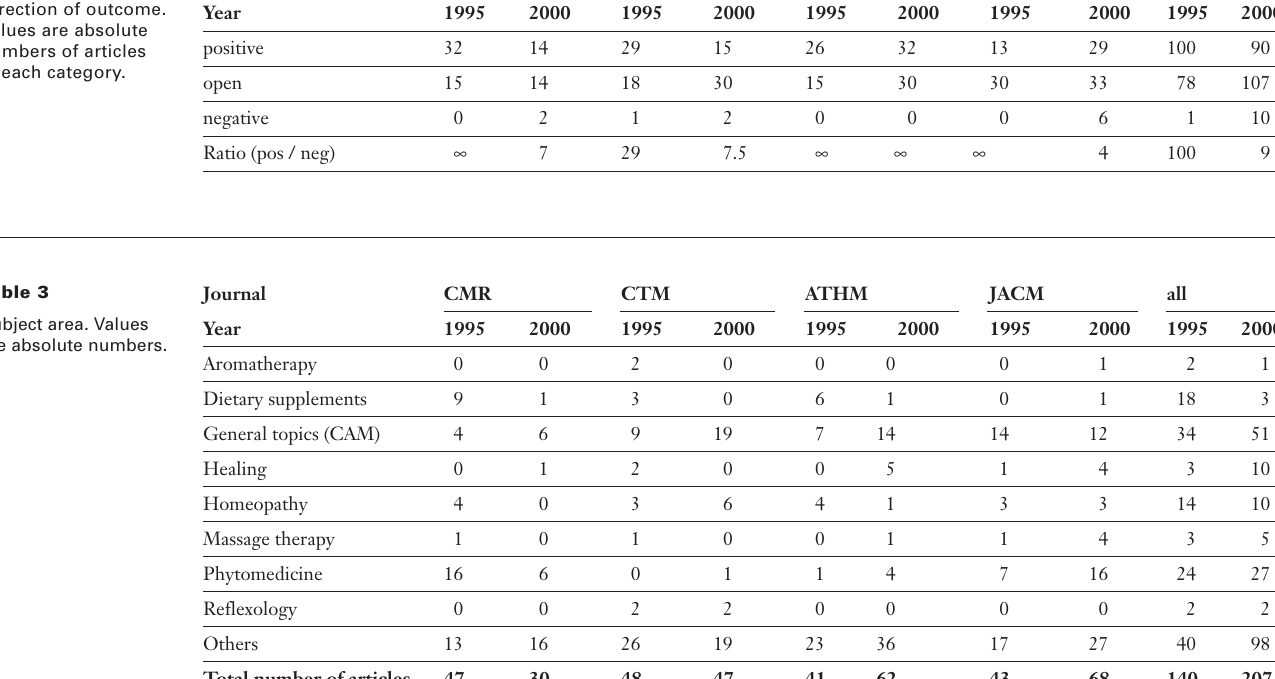
Table 2 Direction of outcome. Values are absolute numbers of articles in each category.